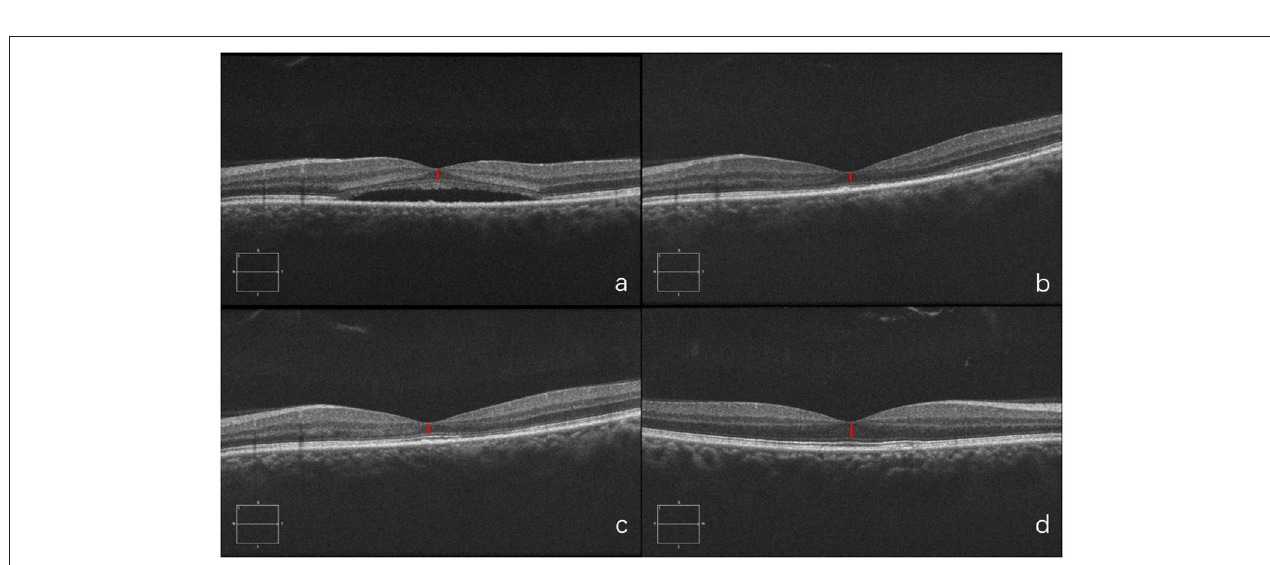
FIGURE 8 | Optical coherence tomography (OCT) of the diseased eye before PDT (a) . 1 month after PDT (b) . 6 months after PDT (c) . and of the fellow healthy eye (d)